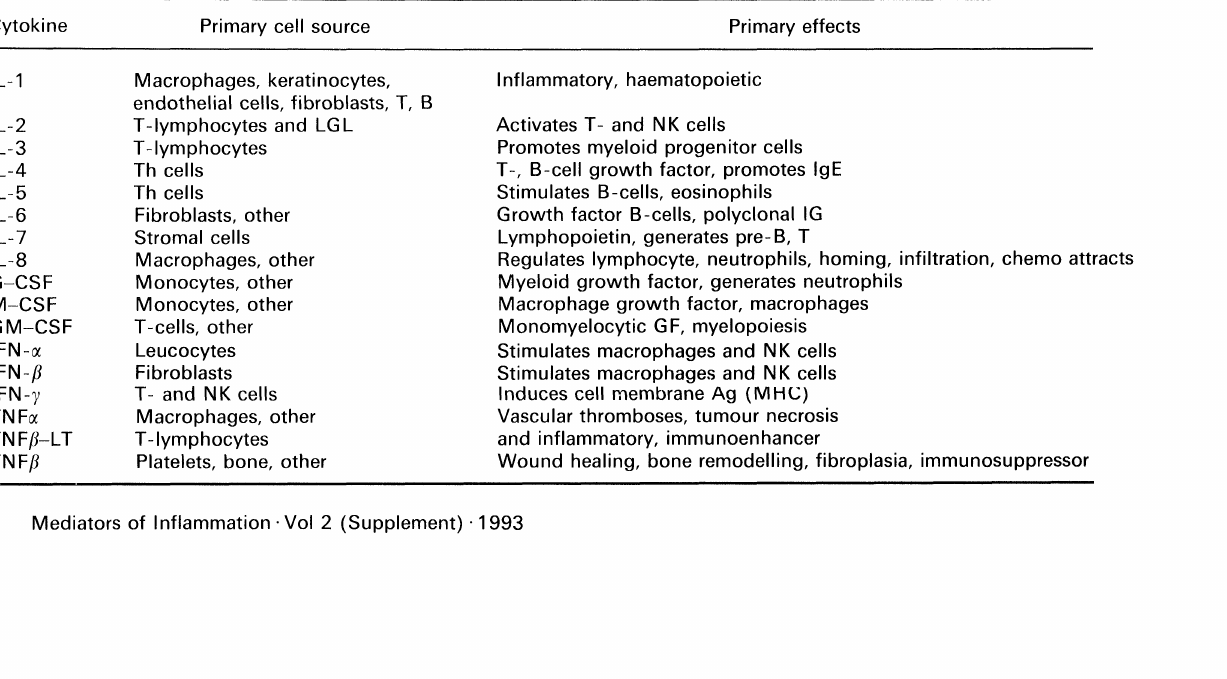
Table 13. Cytokines derived from monocytes/macrophages (monokines) or lymphocytes (lymphokines)